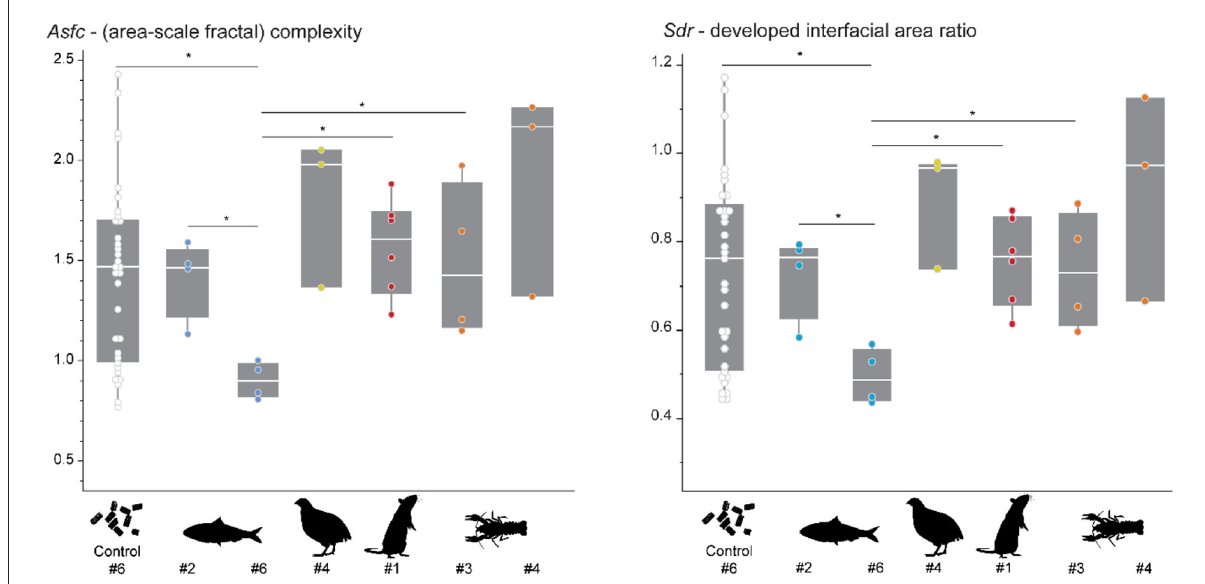
FIGURE3 Asfc and Sdr recorded in different individuals while feeding on the pelleted diet. The control animal (#6) received the pelleted diet over the course of the feeding experiment. For the other individuals, 1–2 teeth were collected immediately before starting the feeding experiment. Each scan is treated as an individual datapoint in this plot. Significance level: * = 0.05. Colored points indicate the diet which was assigned to each individual during the feeding experiment: sardine = blue, quail = yellow, rat = red, crawfish = orange.